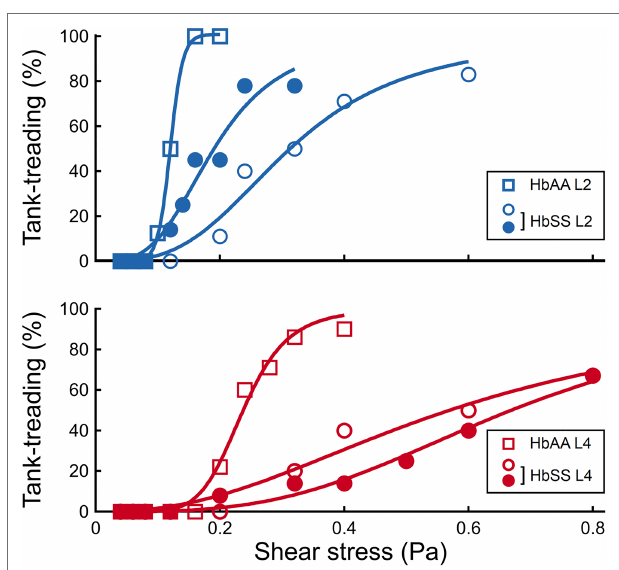
FIGURE 6 | The transition to tank-treading motion is affected by both density and SCD pathology. Percentage of RBCs in tank-treading regime as a function of the shear stress, in the HbAA and HbSS samples, for the L2 and L4 layers,